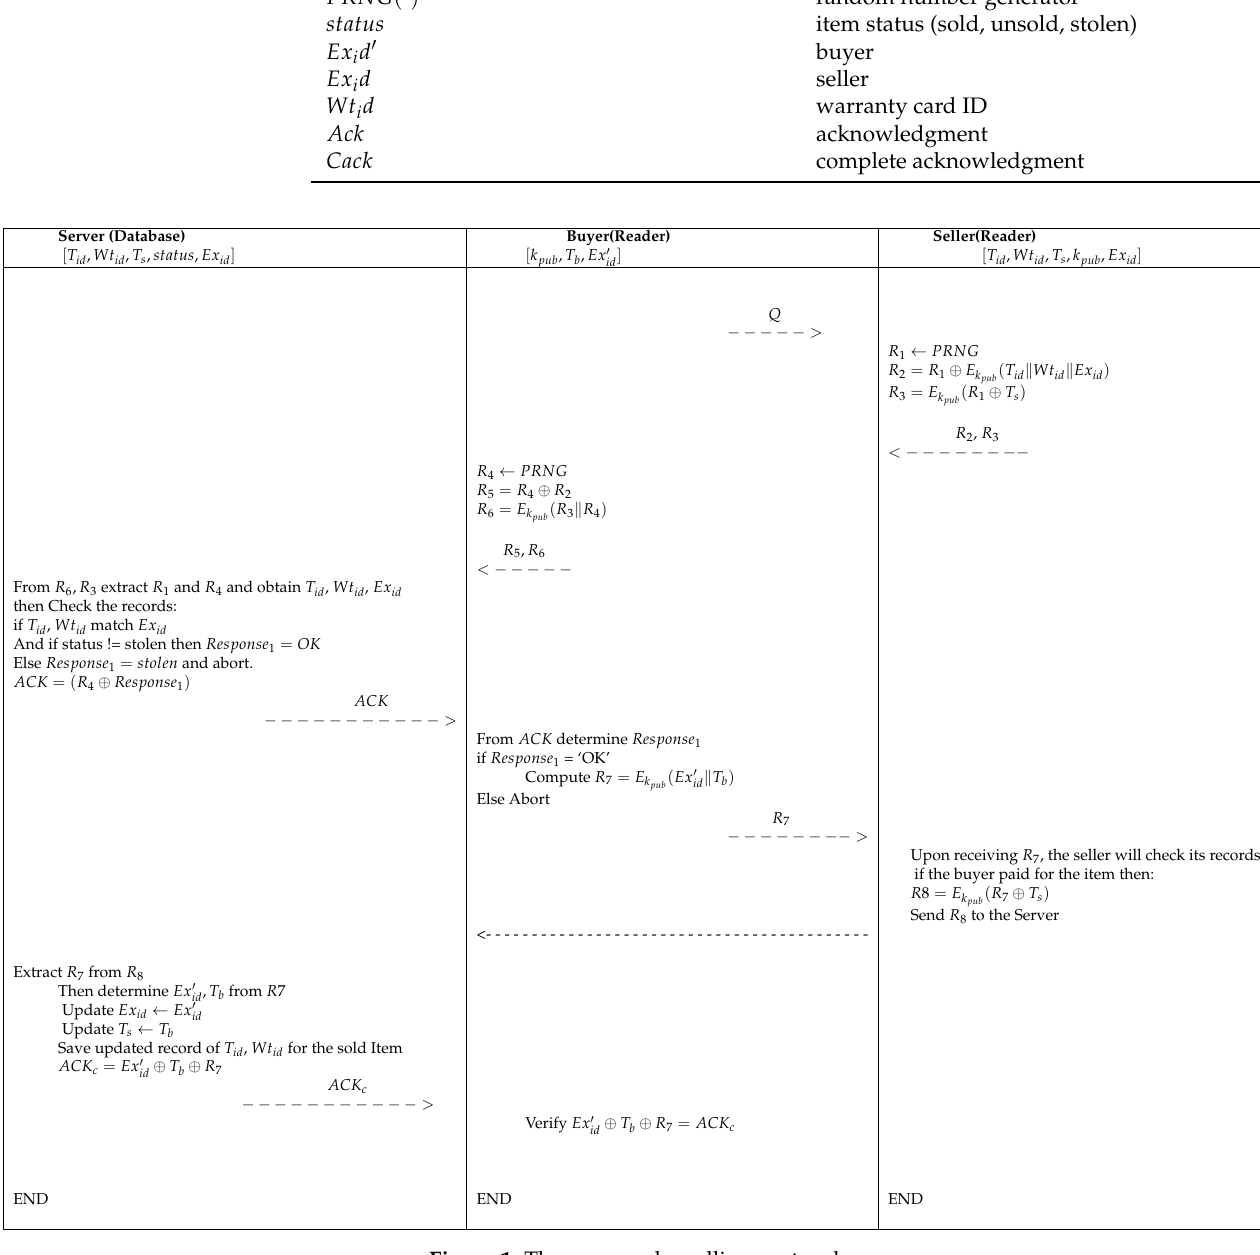
Figure 1. The proposed reselling